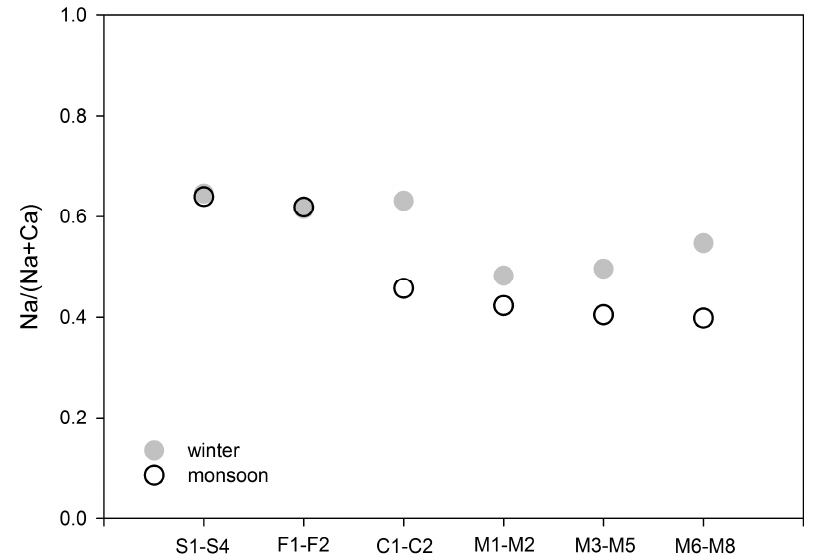
Figure 4. Ratio of Na / (Na + Ca) during winter and monsoon seasons for the Nongkrem and Umiew nested catchments system.